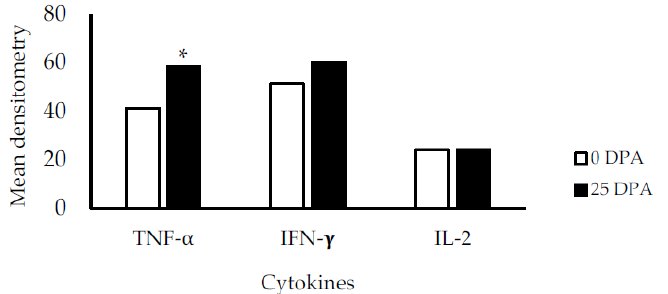
Figure 3. The mean densitometry values for TNF- α in the 0 and 25 DPA groups were 41.3 and 58.3, respectively (* p = 0.001). The mean values for IFN- γ were 51.3 for the 0 DPA group and 59.9 for the 25 DPA group ( p = 0.461). The mean values for IL-2 in the 0 and 25 DPA groups were 24.0 in both cases ( p = 0.990).